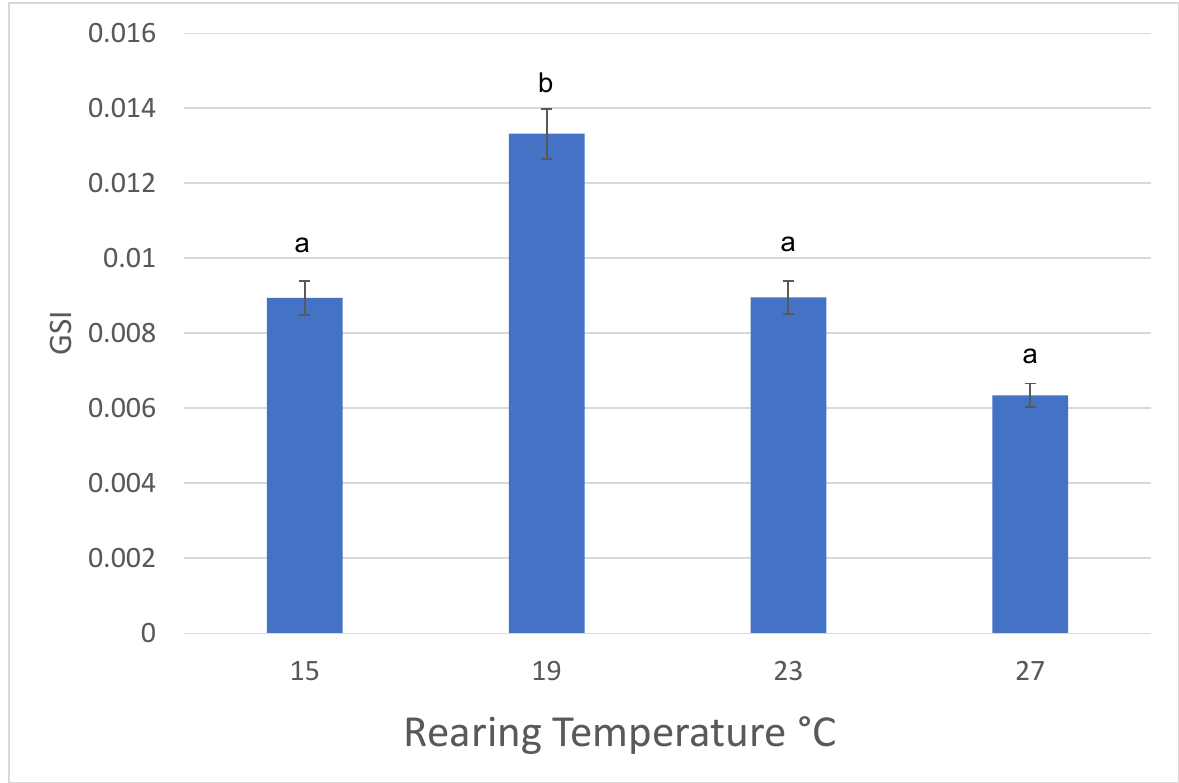
Figure 2. Effects of rearing temperature (15 °C, 19 °C, 23 °C, and 27 °C) on Gonadosomatic Index (GSI) of male axolotls, Ambystoma mexicanum . Different letters indicate statistically significant differences among temperatures. Mean ± standard deviation.